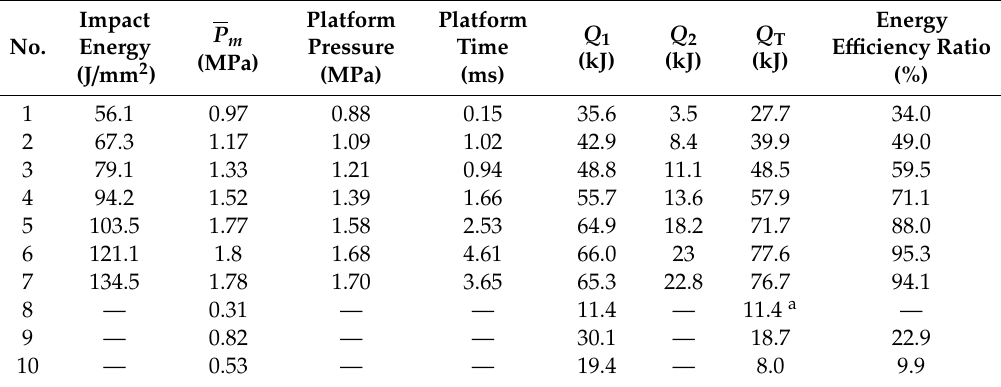
Table 5. Comparison of the pressures and energy-release values of the di ff erent testing schemes.